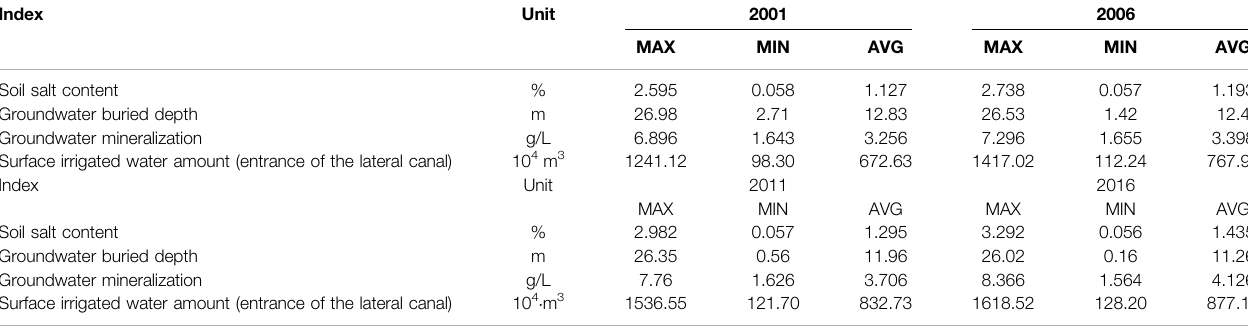
TABLE 1 | Characteristic values of monitoring data of water and salt elements from 2001 to 2016.